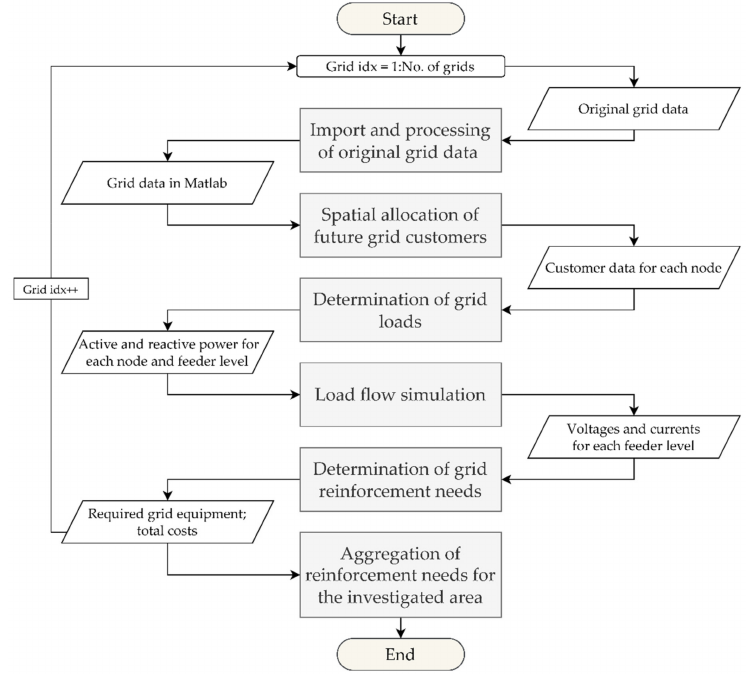
Figure 2. Scheme of the developed fully automated large-scale grid simulation